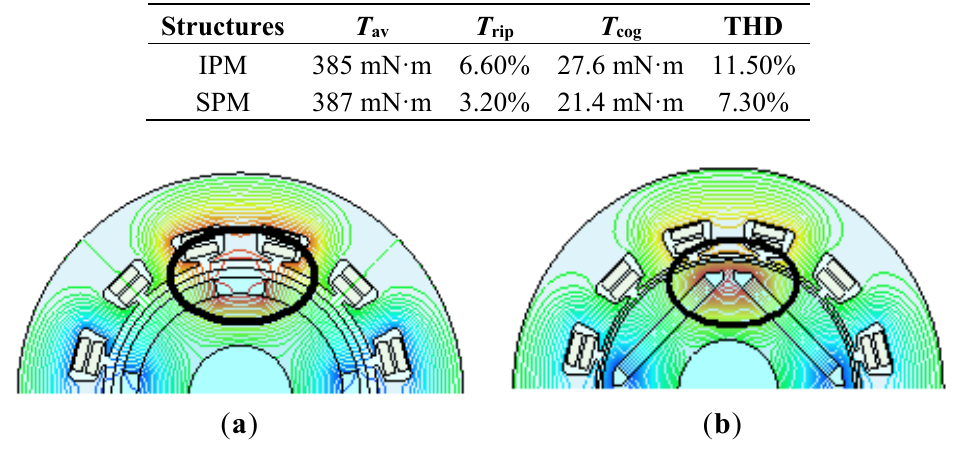
Table 2. Performances Comparison of IPM and SPM machines.